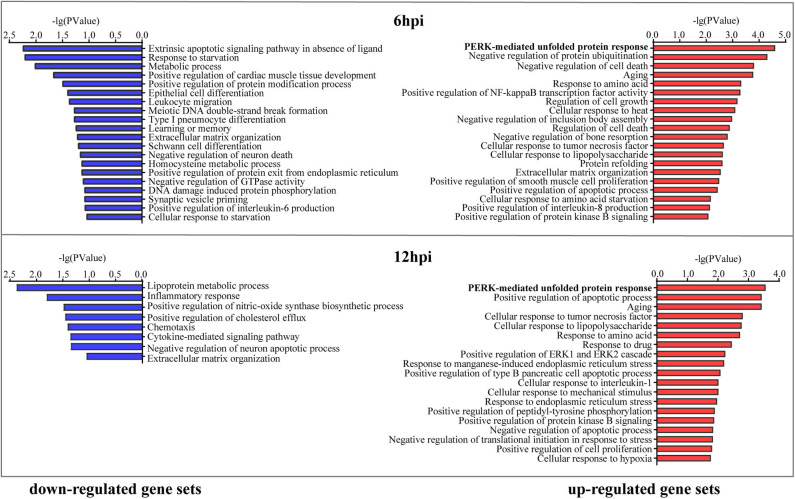
Cellular responses to B. pseudomallei infection analysis. Gene Ontology enrichment analysis was performed on up-regulated gene set and down-regulated gene set at 6 and 12 hpi, respectively. The significantly enriched Gene Ontology processes were ranked by their enrichment scores, and the top 20 processes were shown for each gene set. Blue and red panels represent down-regulated and up-regulated gene sets, respectively.